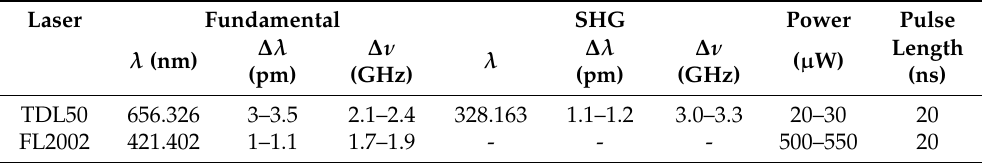
Table 2. Parameters of the excitation